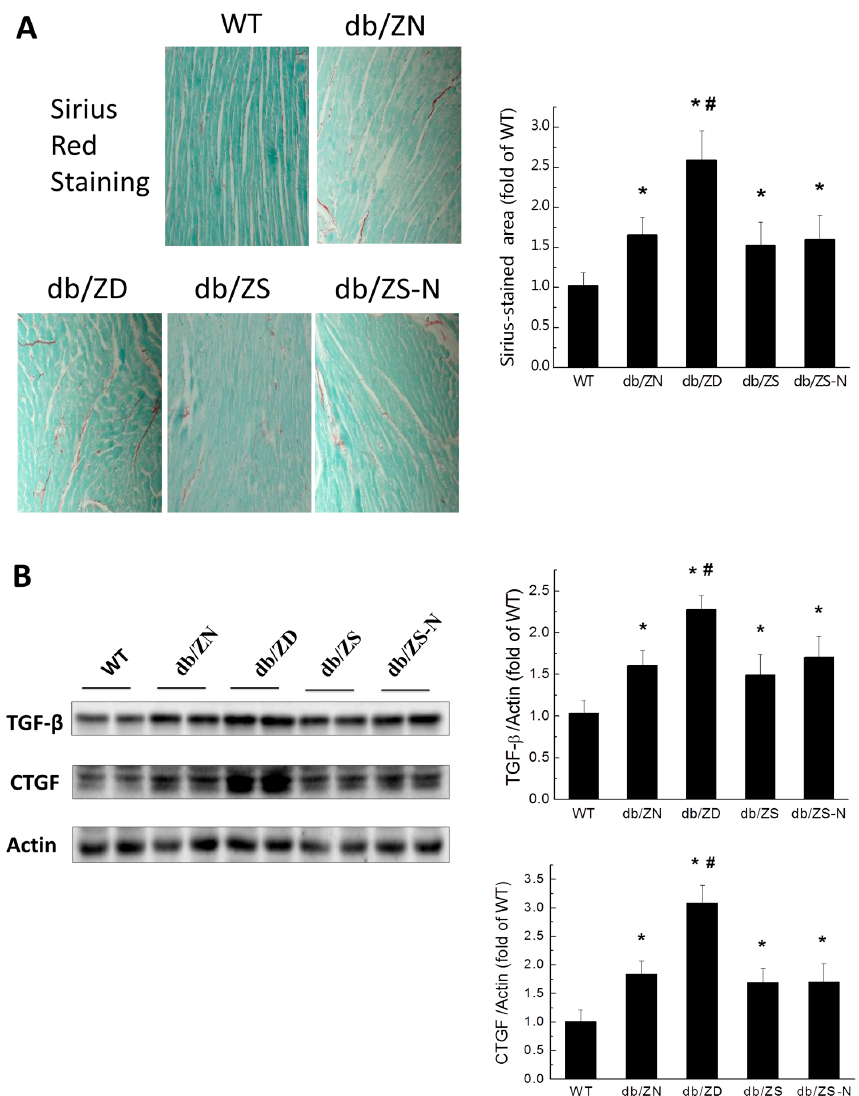
Figure 3. Zn deficiency exacerbates diabetes-induced cardiac fibrosis. Sirius Red Staining ( A ) was used to assess fibrosis in the heart, Scale bar = 25 µM. Western blot was used to evaluate fibrosis related factors ( B ), including transforming growth factor β (TGF- β ) and connective tissue growth factor (CTGF). Data were presented as mean ± SD ( n = 4–7, details in Figure 1). *, p < 0.05 vs. WT group; #, p < 0.05 vs. db/ZN group.